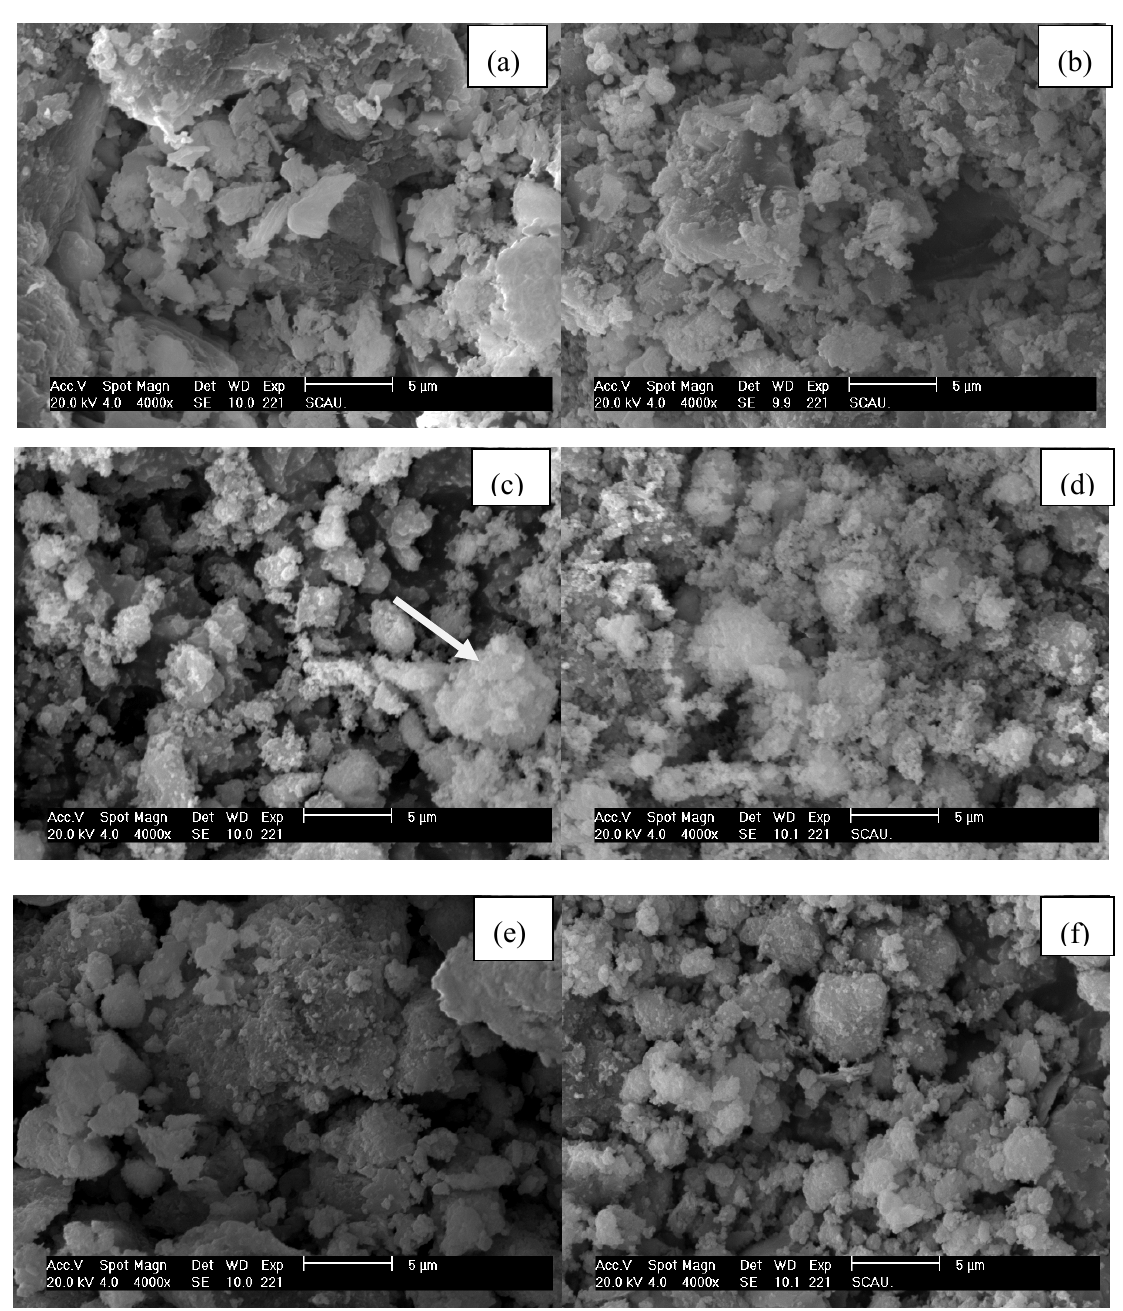
Figure 4. SEM images showing micro-morphological characteristics of ( a ) original GR; ( b ) GR at a Cu dose of 27,500 mg/L; ( c ) GR at a Cu dose of 61,875 mg/L; ( d ) blue precipitates for GR at a Cu dose of 61,875 mg/L; ( e ) original QR; ( f ) QR at a Cu dose of 34,375